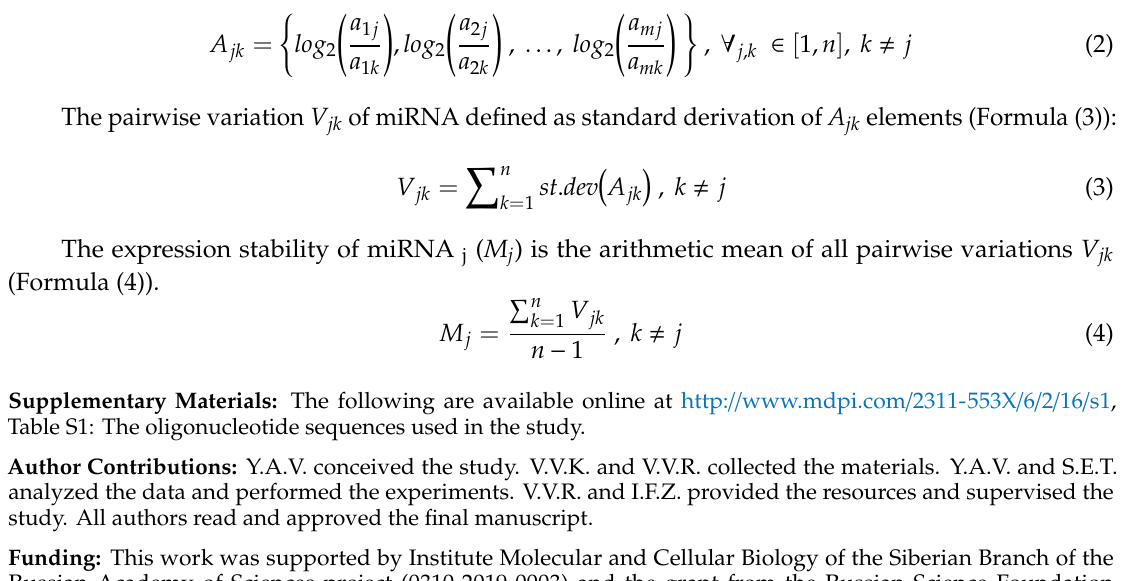
Table S1: The oligonucleotide sequences used in the